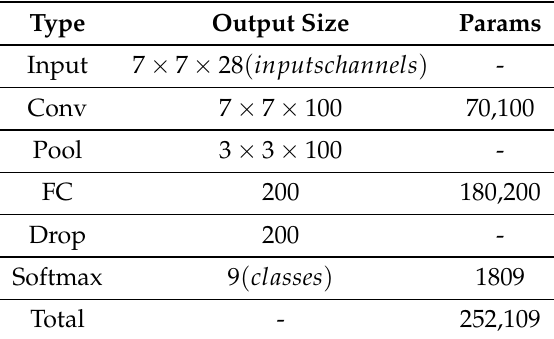
Table 2. Architecture details of the CNNpatch model: d stands for the input channels, and c stands for the number of